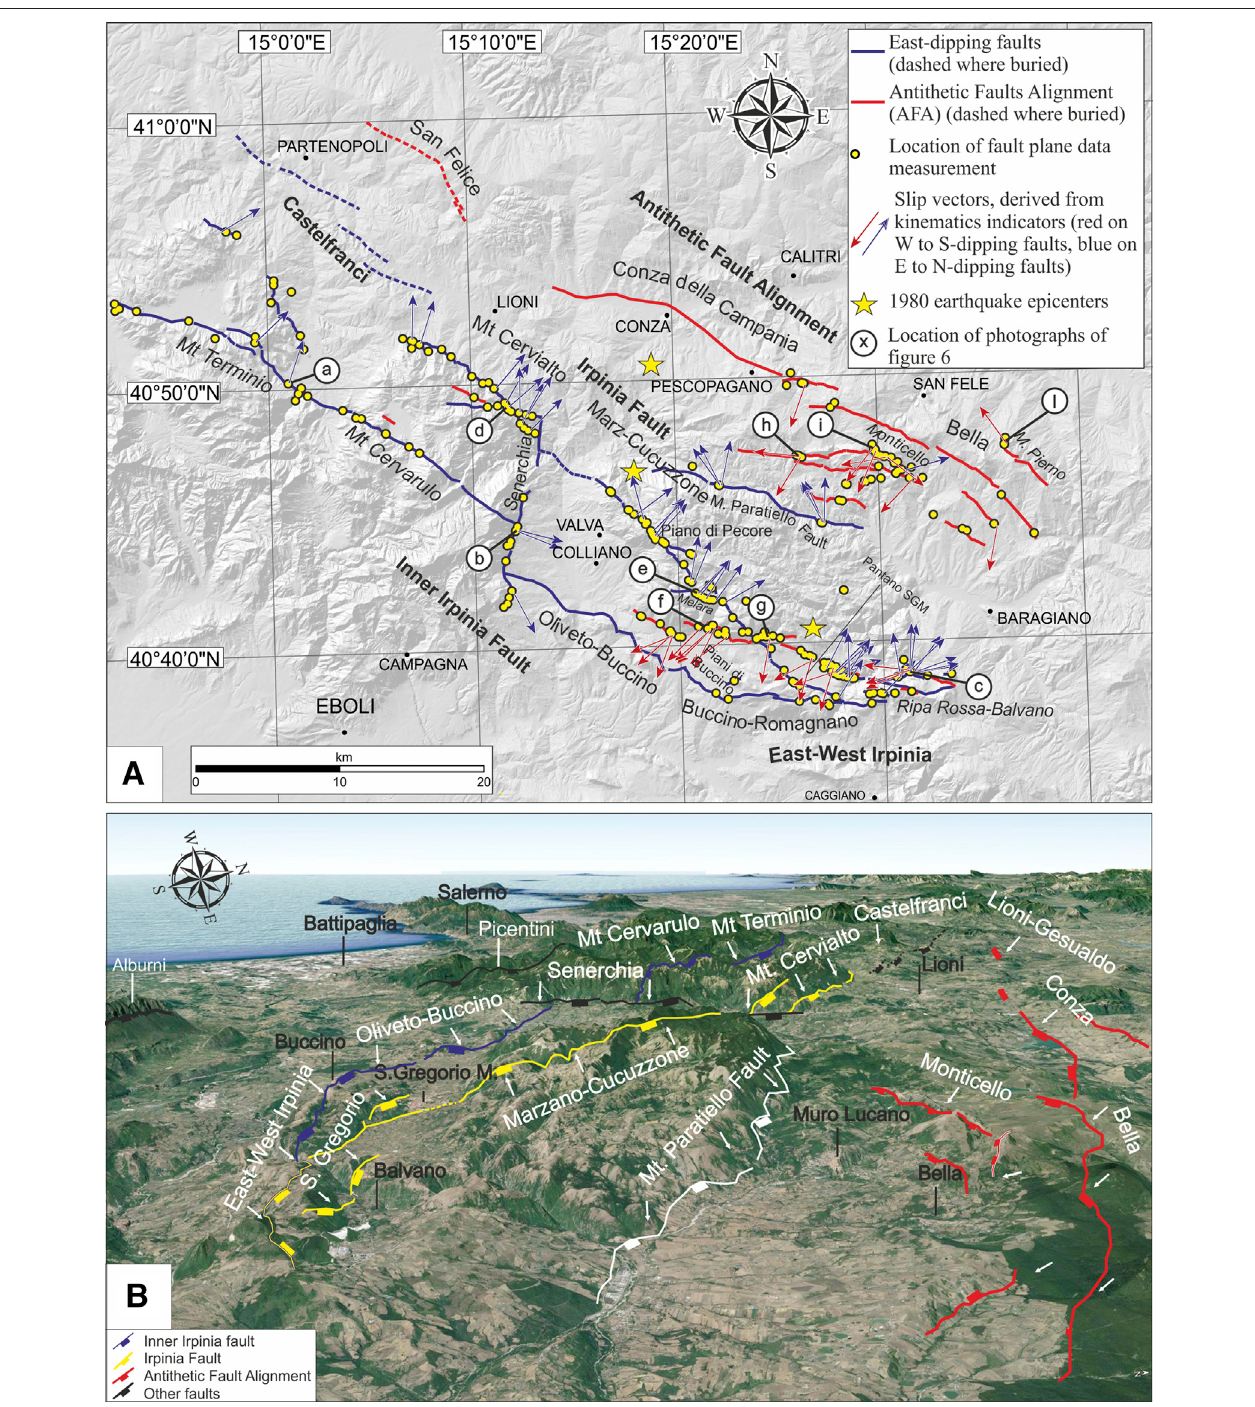
FIGURE3|(A) SummarymapofthereconstructedtectonicstructuresandoftheacquireddataintheCampania-Lucania1980earthquakeepicentralarea.Arrows show the slip vectors derived from kinematic indicators and reported together with the structural data of the fault planes in the stereoplots of Figure 4 . Yellow circles representthelocationofthestructuraldatasummarizedinstereoplotsof Figure4 andlistedin SupplementaryTableS1 .Lettersinwhitecirclesrefertophotographsof Figure 6. (B) Panoramic view looking WNW of the entire study area. The fault alignments are shown in their subdivision into segments.